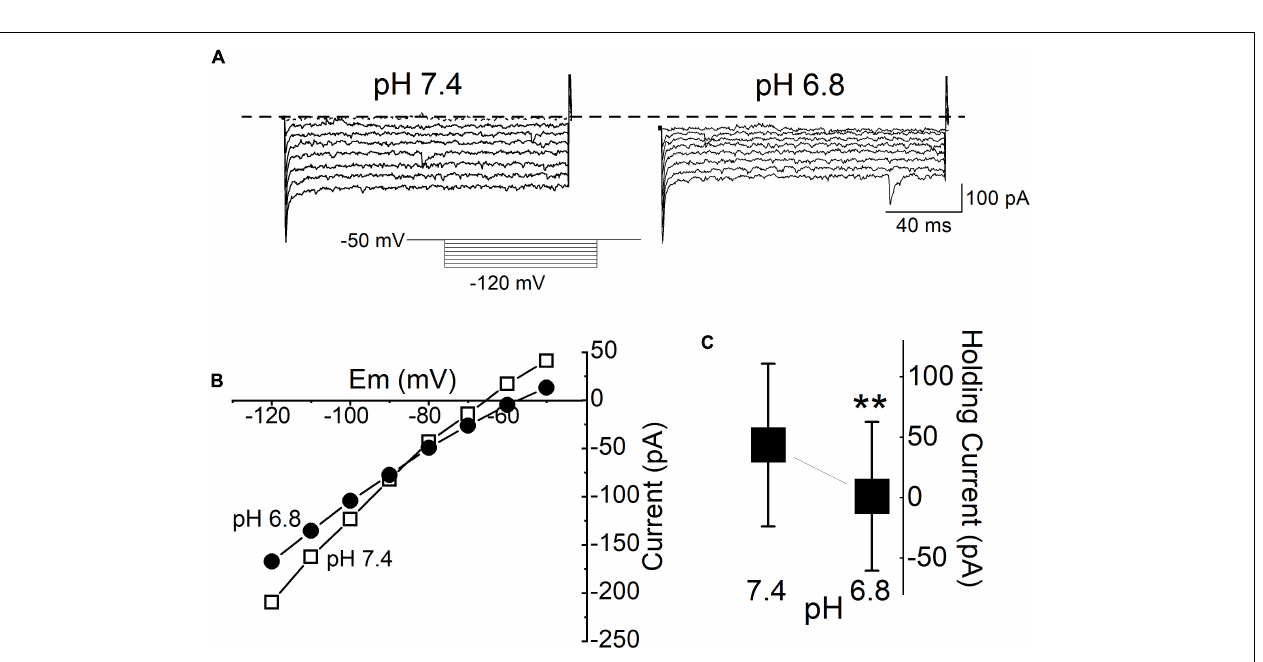
FIGURE 5 | Background K + conductance was reduced by acidification. (A) Current traces in response to polarizing voltage steps between -50 and -120 mV from the holding potential of (-50 mV) applied to the same cell during application of pH 7.4 and pH 6.8 ACSF. All traces were recorded during the application of TTX (1 µ M). The current response was measured 10 ms after the onset of the voltage step to avoid inclusion of the transient capacitance. (B) The I-V relationship measured from the same cell in (A) . (C) Mean baseline holding current at normal ACSF (pH 7.4) and during acidification (pH 6.8). Each bar and whisker represent the mean ± SDM from 5 different cells. ** P <